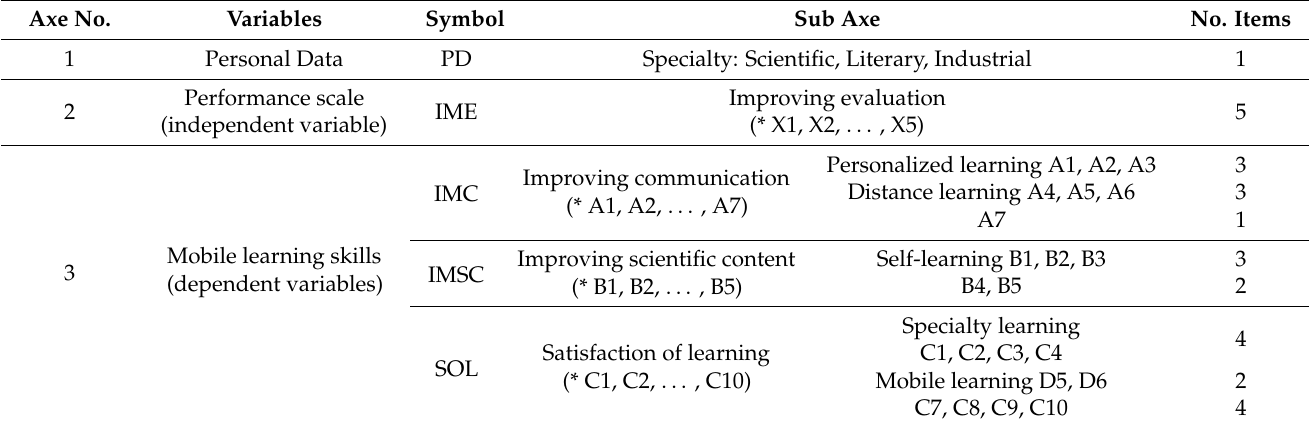
Table 1. Questionnaire variables